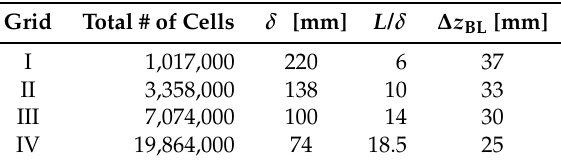
Table 2. Grid characteristics: total number of cells, approximate cell size ( δ ), approximate number of cells ( L / δ ) spanning the characteristic length L , and grid size ( ∆ z BL ) in z direction at the ceiling ( z = 3 m).